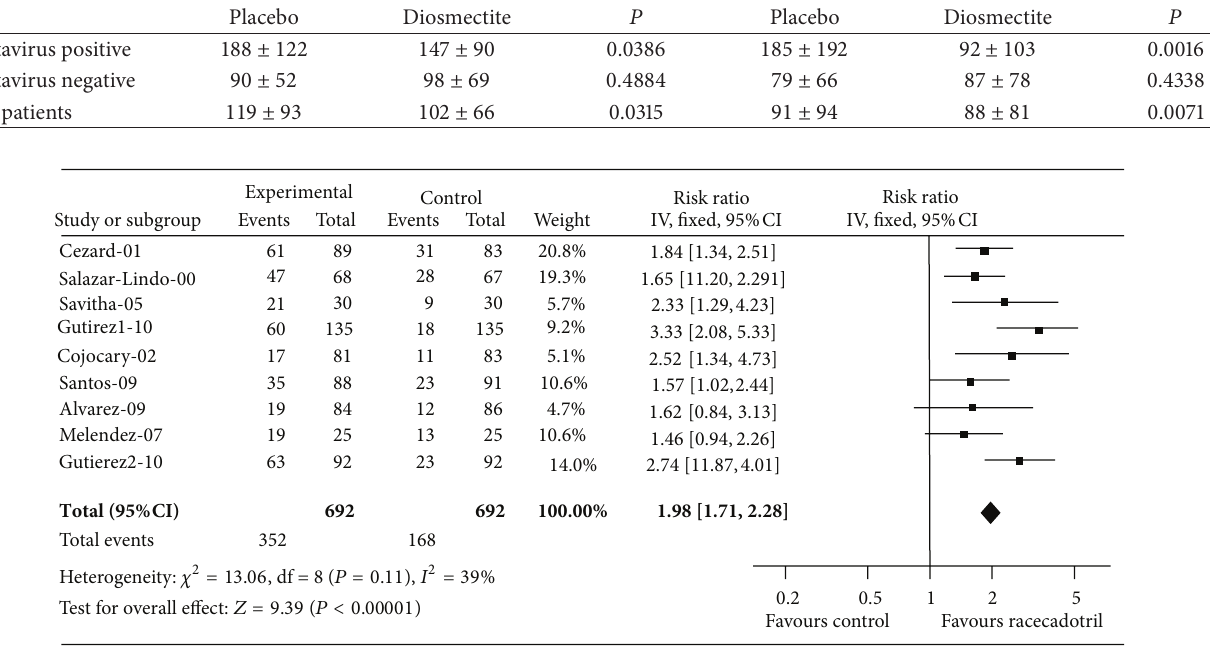
5Heterogeneity: 𝜒 2 = 13.06 , df = 8 ( 𝑃 = 0.11 ), 𝐼 2 = 39 % Test for overall effect: 𝑍 = 9.39 ( 𝑃 < 0.00001 ) Figure 5: Efficacy of racecadotril: responder rate defined as patients with a short diarrhoea duration (less than 2 days). Summary means adjusted for baseline conditions (rotavirus serostatus, dehydration). Reproduced with permission from Lehert et al. 2011